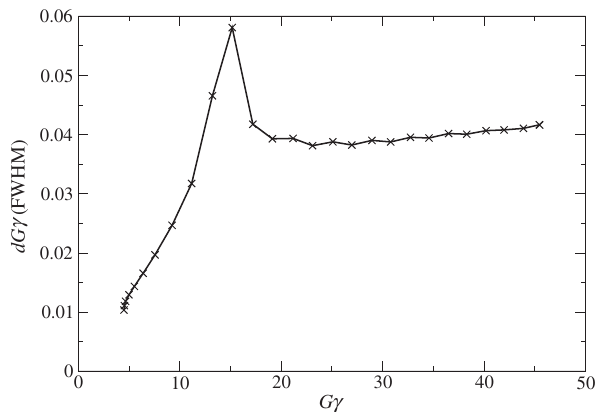
FIG. 6. The dG γ FWHM along the ramp as function of G γ . Note the flatness of the dG γ curve beyond G γ ¼ 20 . The reduction in dp=p together with the increase in p result in the spread in the beam G γ staying about constant at